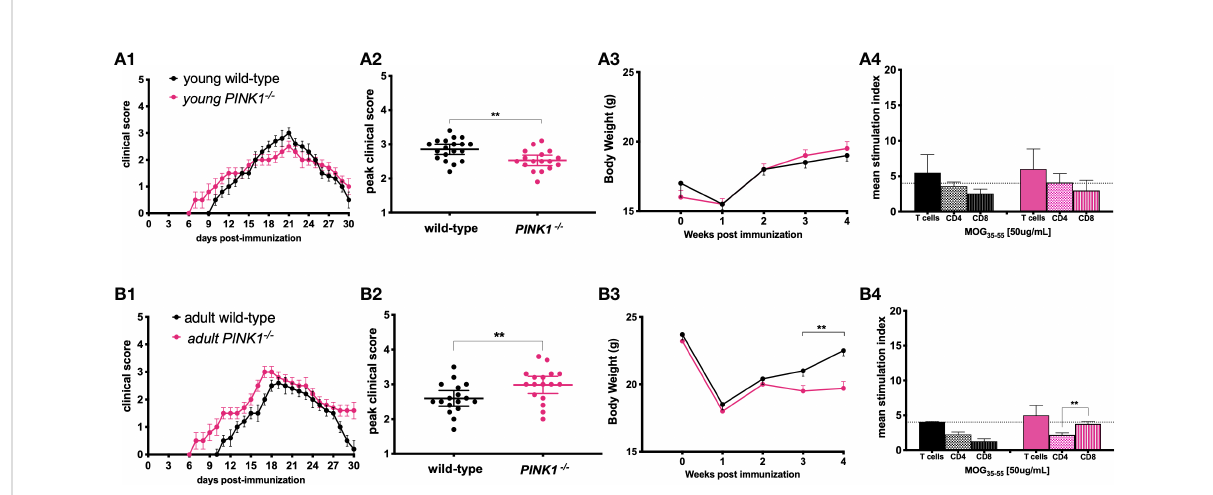
FIGURE 1 EAE development in PINK1 -/- mice. Graph reports EAE mice clinical score evaluated daily (A1, B1) , the peak clinical scores (A2, B2) , body weight (A3, B3) , and T-cell proliferative response to MOG 35 – 55 peptide (A4, B4) . The data show one experiment (N =10 mice/group) of three independent ones for the proliferation assay. Data are expressed as means ± SD and mean with 95% con fi dent interval calculated by ANOVA followed by Bonferroni ’ s posthoc test or Mann-Whitney u test. * p < 0.0, ** p < 0.01, *** p <